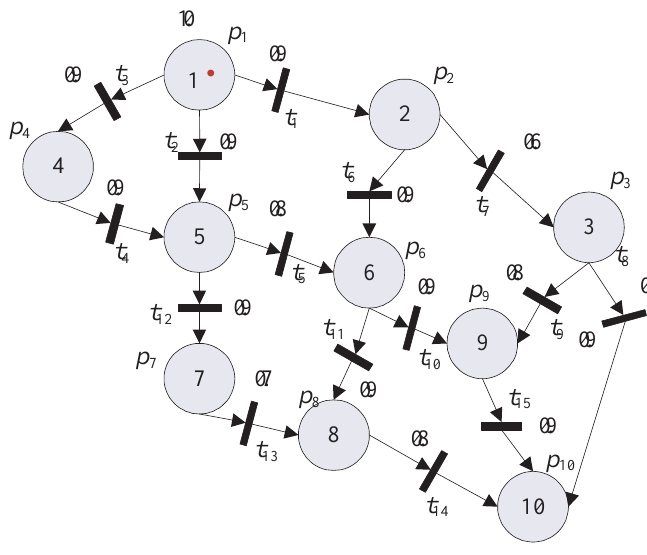
Figure 8. FPN model of topology of cluster